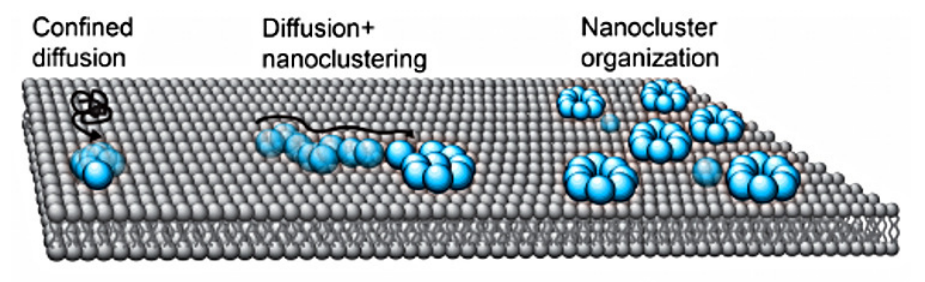
Figure 15. Formation of naonclusters on a lipid bilayer. From Sartorel et al.